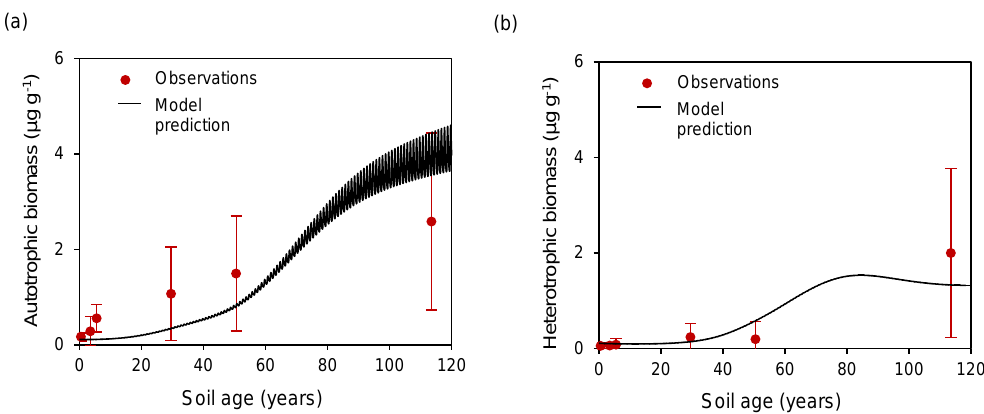
Figure 7. Model predictions of (a) autotrophic and (b) heterotrophic biomass (black line) compared to observational data (red) derived from microscopy.